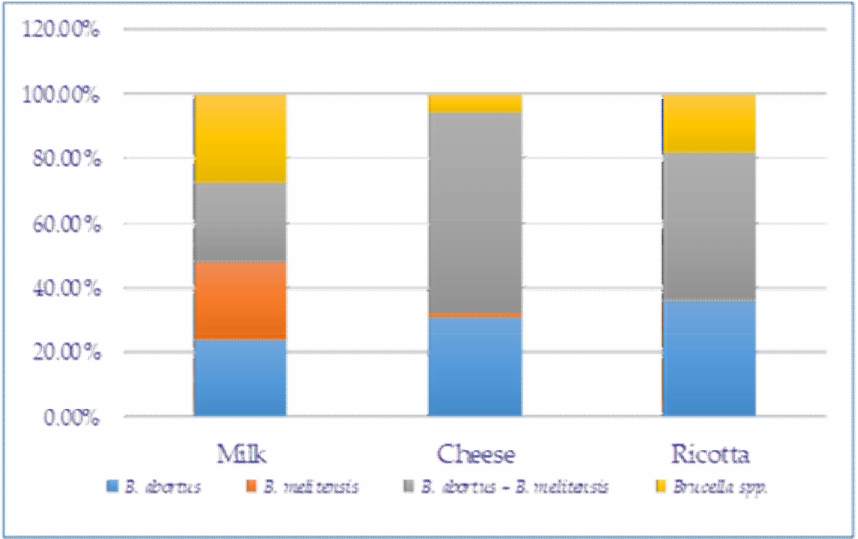
(Table 2). The contamination rates of each sample type with B. abortus and/or B. melitensis are presented in Figure 3.